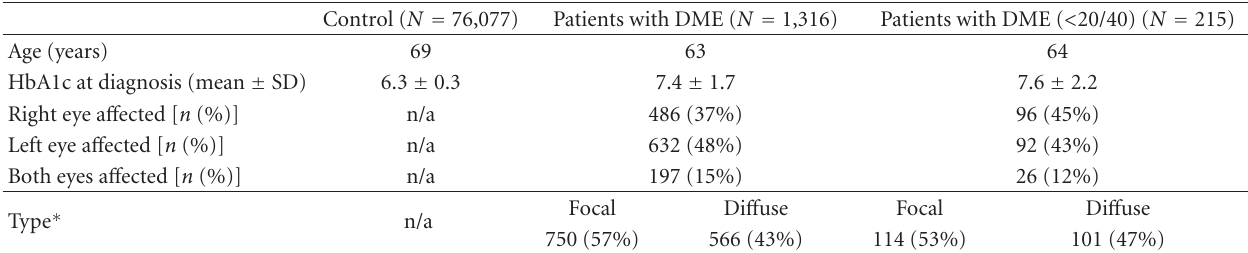
Table 4: Visual impairment in patients with DME.